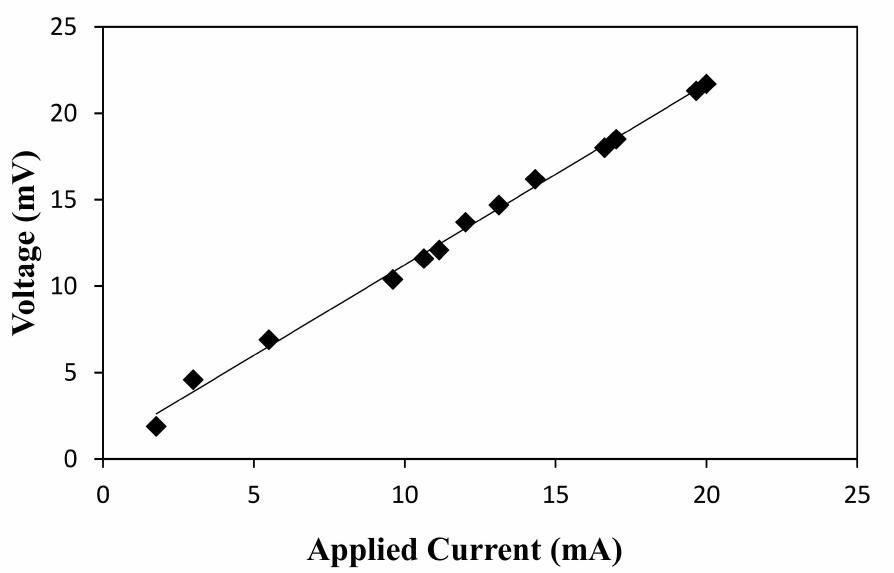
Figure 16. Voltage obtained corresponding to the applied current in four-probe